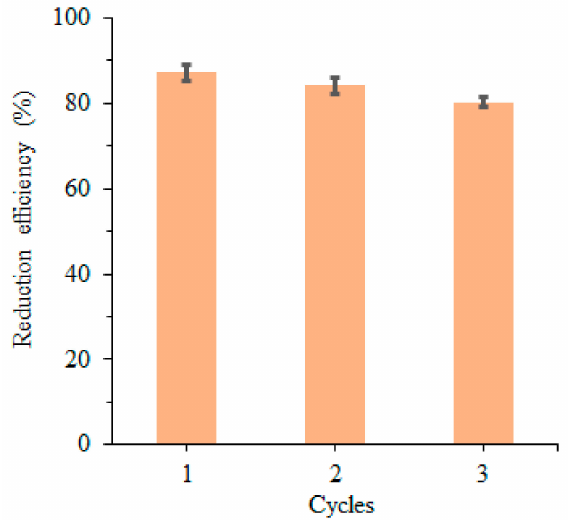
Figure 11. Recyclability of biogenic CAg-nPs catalyst for reduction of CR (0.216 mM) in the presence of NaBH 4 (24.03 mM) and catalyst (8.42 mg / mL) at an ambient